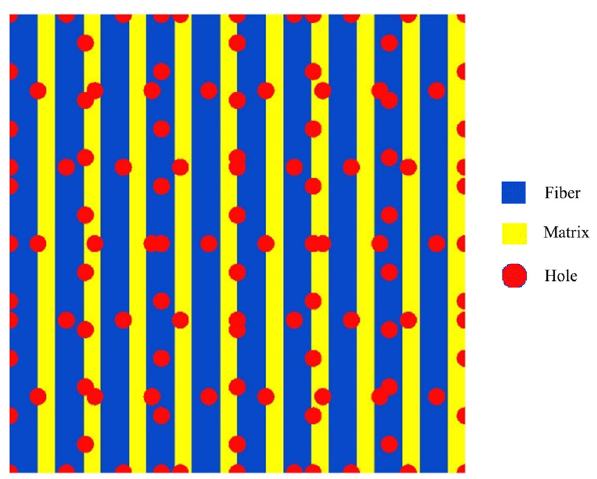
Figure 2: Minimum period distribution of needle